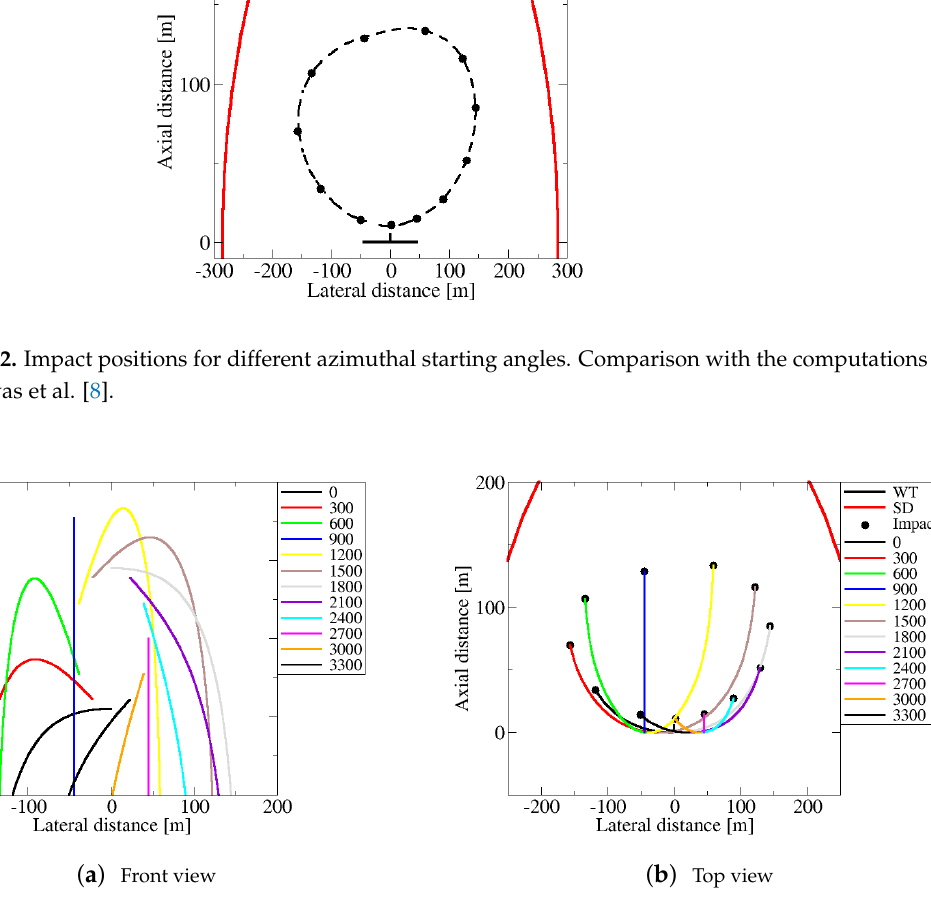
Figure 3. Trajectories of ice chunks released at different azimuthal positions.